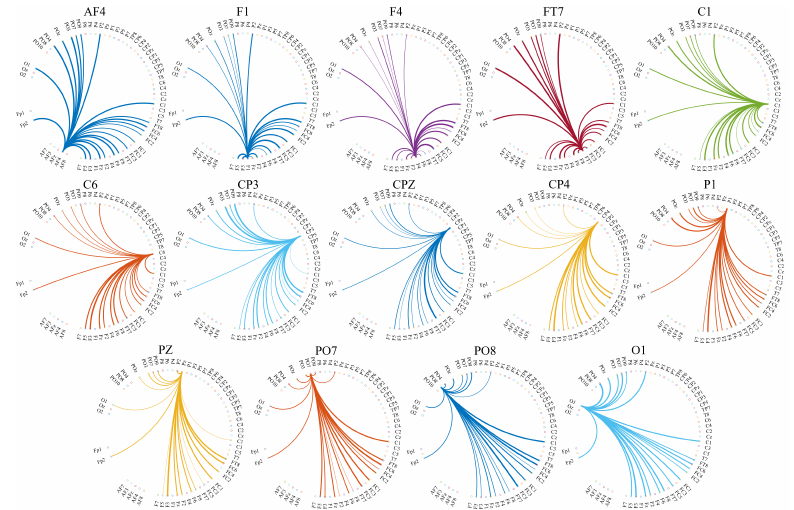
Figure A6. Eyes-Open (EO) setting. Transfer of information from (i.e., out-degree) AF4, F1, F4, FT7, CP3, CP4, CPZ, C1, C6, P1, PZ, PO7, PO8, and O1 to the other cortical regions in the case of HIGH stress-susceptible group. In each subplot, the source of information transfer (e.g., AF4, F1, etc.) is the one from which all connections are originated. They are labeled at the top of each subplot. The recipients of information (i.e., channels on the other cortical regions) are the ones at the other end of these outreaching arches.